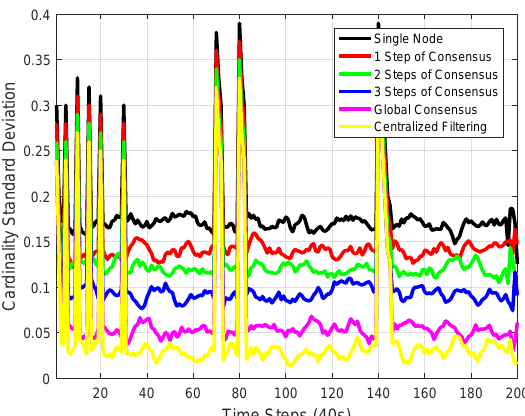
Figure 11. The standard deviation of the estimated cardinality of single-node M δ -GLMB, 1-step consensus, 2-step consensus, 3-step consensus, 5-node consensus, and centralized M δ -GLMB filtering versus time.